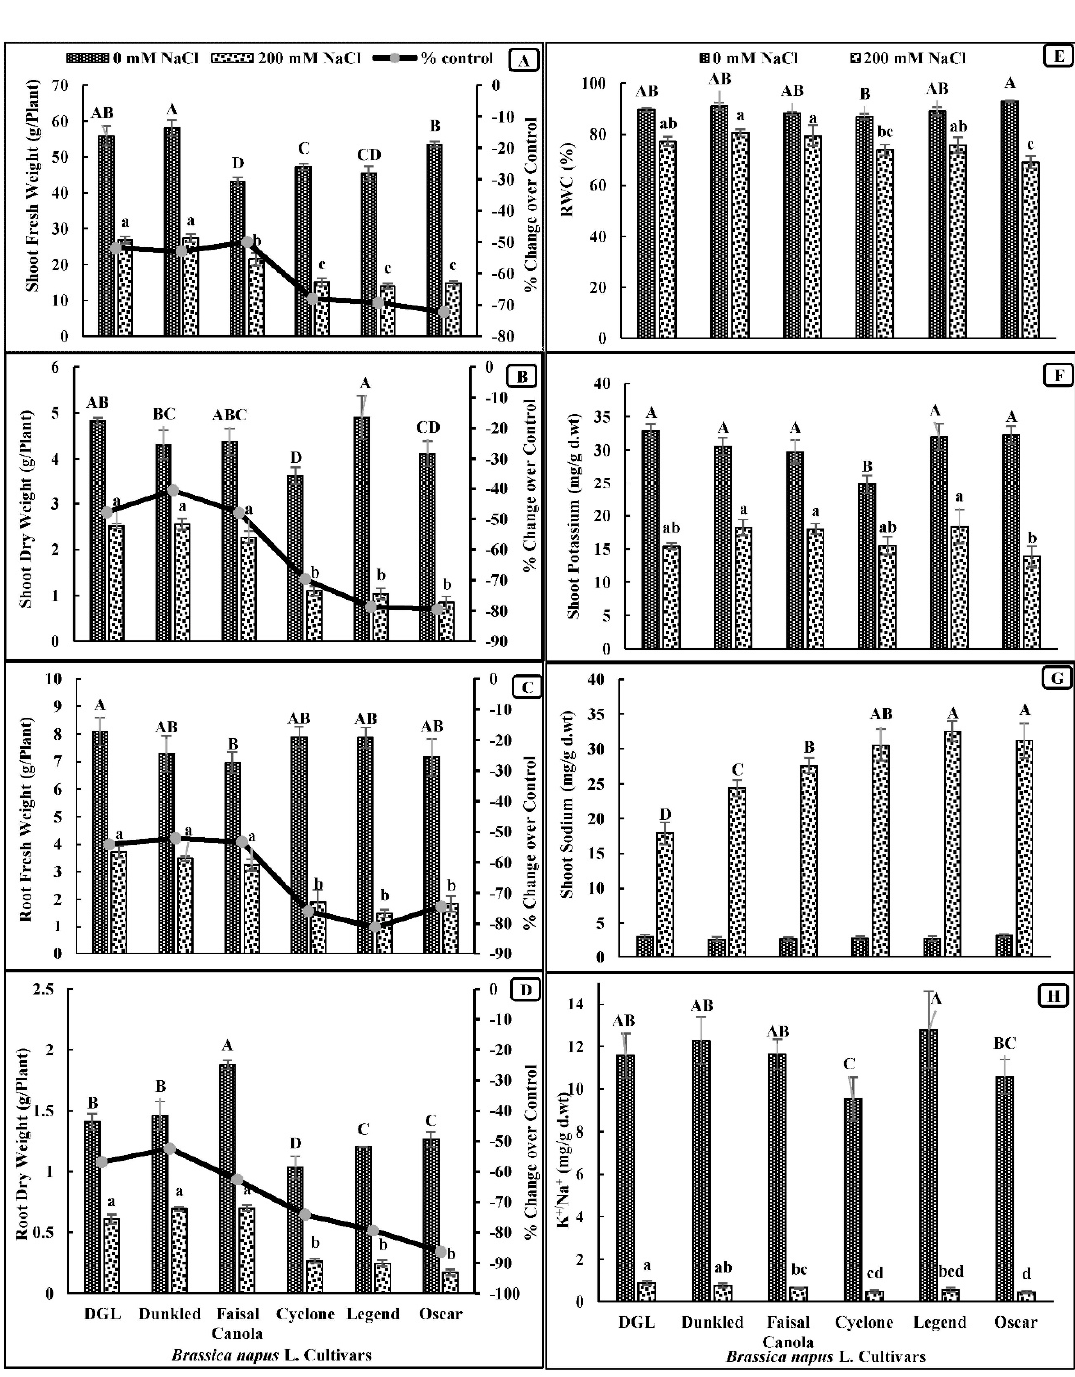
Figure 1. Growth and ion accumulation in seven-week-old plants of canola when three-week-old plants were subjected to salt stress (0 mM and 200 mM NaCl) for four weeks. ( A ) Shoot fresh weight. ( B ) Shoot dry weight. ( C ) Root fresh weight. ( D ) Root dry weight. ( E ) Relative water content. ( F ) Shoot Na + . ( G ) Shoot K + . ( H ) Shoot K + /Na + ratio. n = 4. Means were compared with LSD 0.05 of the interaction term (Salinity × Cvs) only. Means with the letters (A–B) for control and (a–b) for saline differed significantly at 5% probability.